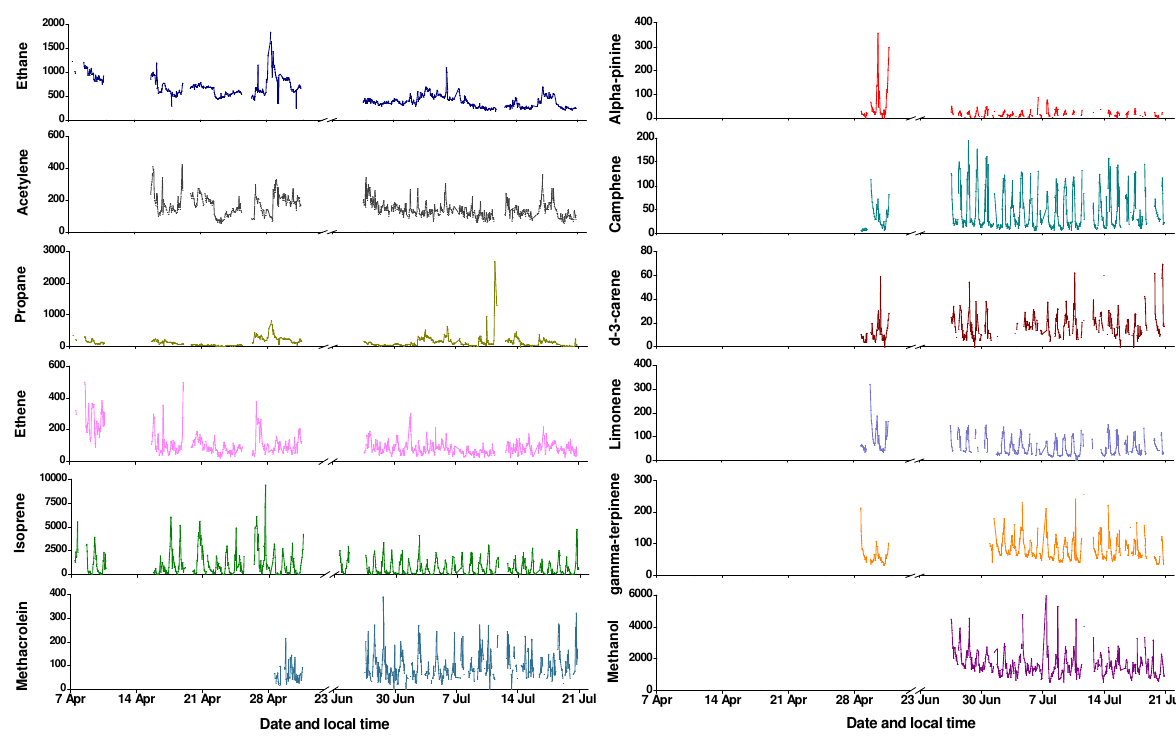
Fig. 2. Time-resolved measurements of isoprene and its oxidation product methacrolein, the monoterpenes α -pinene, camphene, 1 -3- carene, limonene and γ -terpinene, methanol, and selected other VOCs thought to be of primarily anthropogenic origin (ethane, acetylene Figure 2. Time-resolved measurements of isoprene and its oxidation product 653 and propane) at the ground-based site at Bukit Atur during April 2008 (OP3-I) and June–July 2008 (OP3-III). Only limited monoterpene and OVOC data is shown from the first measurement period, due to instrument methacrolein, the monoterpenes α -pinene, camphene, ∆ -3-carene, limonene and γ -654 terpinene, methanol, and selected other VOC thought to be of primarily anthropogenic 655 origin (ethane, acetylene and propane) at the ground-based site at Bukit Atur during April 656 2008 (OP3-I) and June-July 2008 (OP3-III). Only limited monoterpene and OVOC data 657 is shown from the first measurement period, due to instrument failures. 658